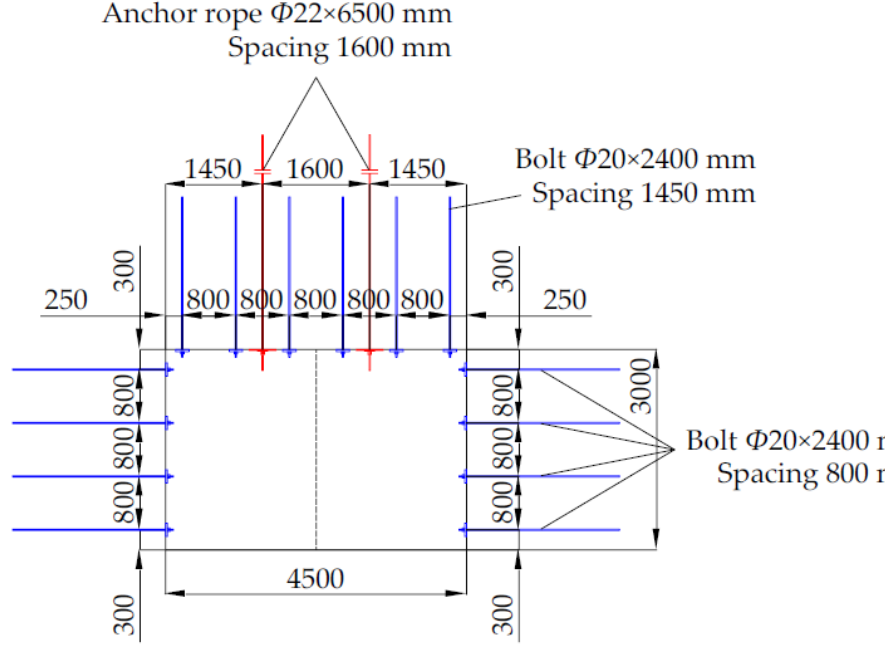
Figure 18. Section of the return-air roadway support in working face 3204.